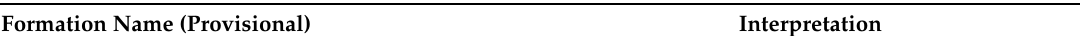
Table 4. Interpreting depositional environments in the Middle Son valley, north-central India. (Modified and updated from [61]).